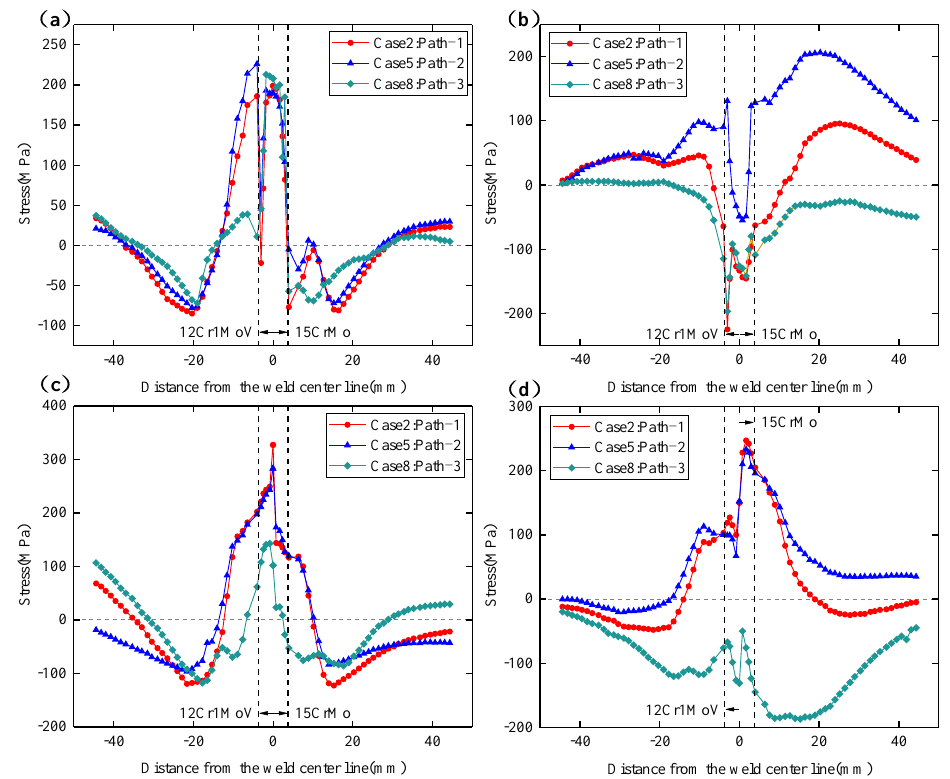
Figure 16. Circumferential and axial residual stress distribution of Case 2, Case 5 and Case 8 at 90° section. ( a ) Circumferential residual stress on the outer surface. ( b ) Axial residual stress on the outer surface. ( c ) Circumferential residual stress on the inner surface. ( d ) Axial residual stress on the inner surface.